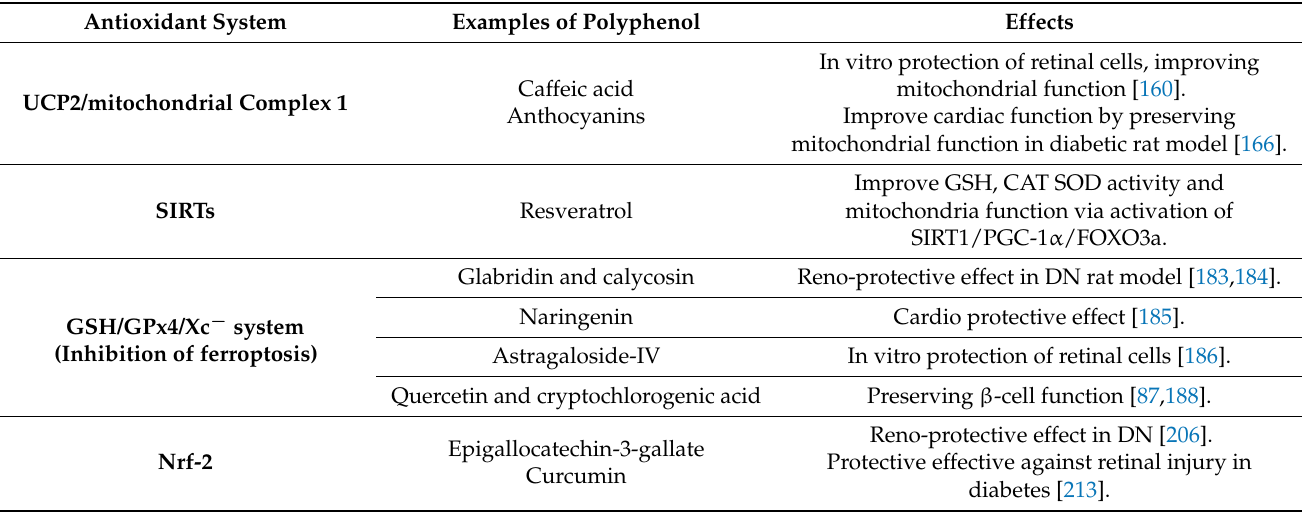
Table 1. Summary of examples of polyphenols and their effects on endogenous antioxidant systems in diabetic